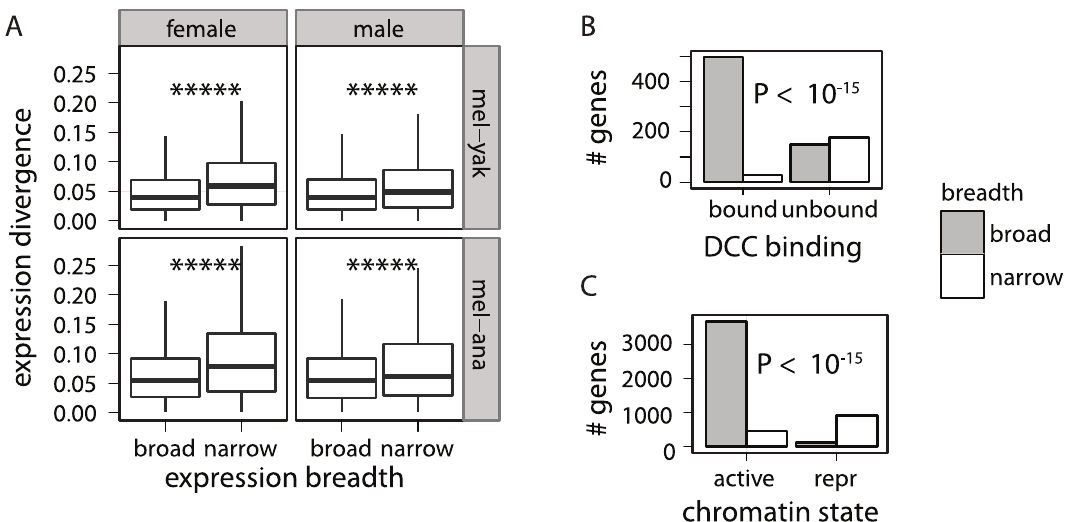
Figure 7. Association between expression breadth, DCC binding, chromatin state, and expression divergence. Genes were classified based on their expression breadth, whether they are bound by the DCC, and whether they are in transcriptionally active or repressive (repr) chromatin (based on data from S2 cells). (A) Boxplots show the pairwise divergence in expression between 1:1:1 orthologs in the D. melanogaster (mel) and D. yakuba (yak) or D. ananassae (ana) genomes for broadly and narrowly expressed genes (see Figure 5). Mann-Whitney U tests were used to assess significant differences in expression divergence between broadly and narrowly expressed genes (***** P v 0 : 000005 ). (B) X-linked broadly expressed (gray) and narrowly expressed (white) genes were divided into those that are bound and unbound by the DCC. (C) Broadly expressed (gray) and narrowly expressed (white) genes were divided into those that are in transcriptionally active and repressive chromatin. (B–C) Fisher’s exact test was used to determine if there is a non-random distribution of genes in the four classes.